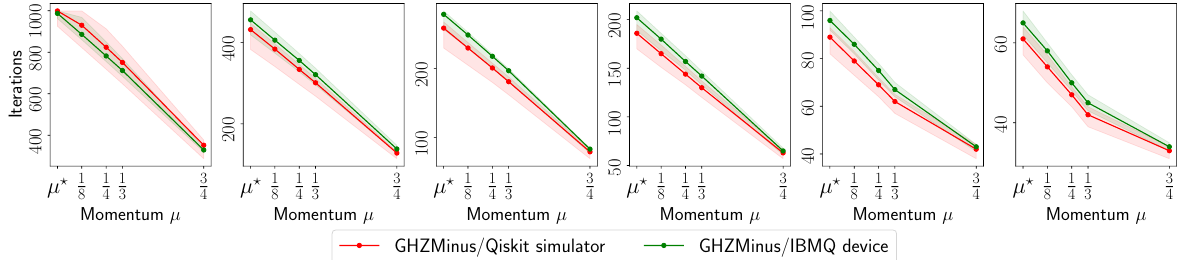
( 8 ) circuit using using real measure- −